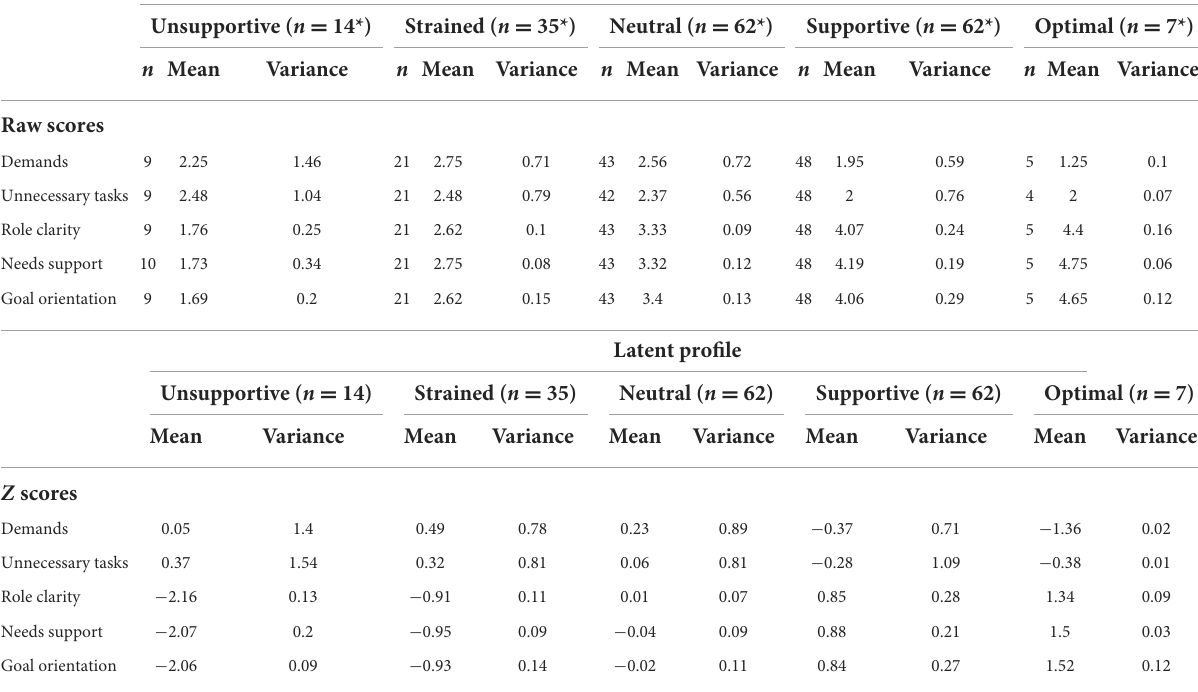
TABLE 5 Means and variances of the raw scores and z scores of the five co-care factors at T2 ( N =